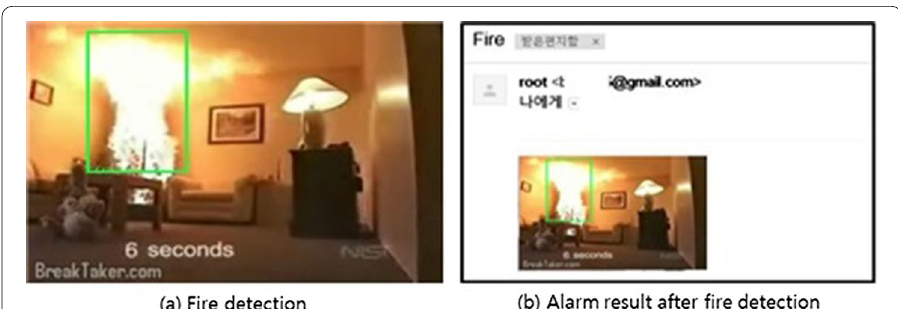
Fig. 18 Notify in case of an abnormal situation (fire)